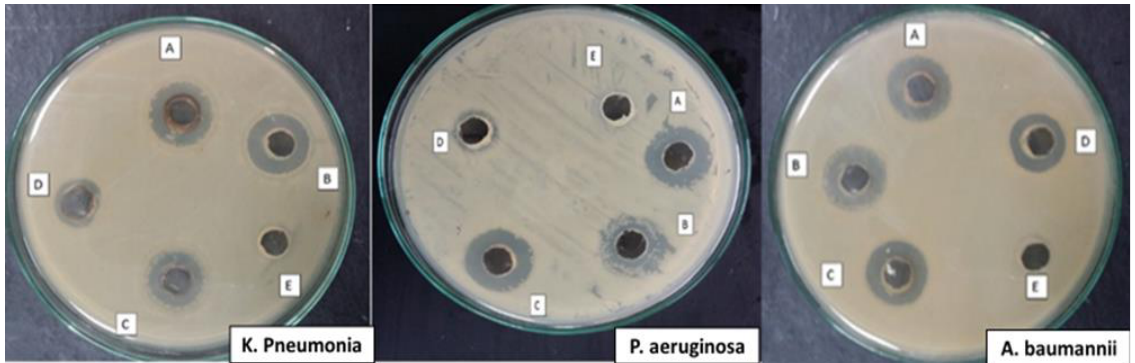
Figure 12. Effect of Acinetobacter baumannii nanoparticles on pathogenic bacteria Klebsiella pneumonia, Pseudomonas aeruginosa, Acinetobacter baumannii, A for AgNPs alone, B for antibiotic alone, C for antibiotic combination with